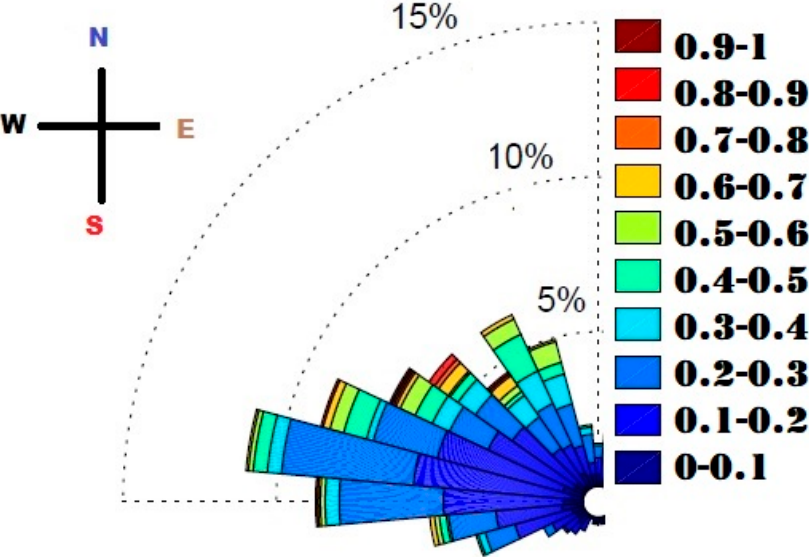
Figure 3. The wind rose presentation of wind direction and wind speed (m s − 1 ) during the experiment period of Sept–Nov 2018. The prevailing wind direction of West-North-West is clearly observed.